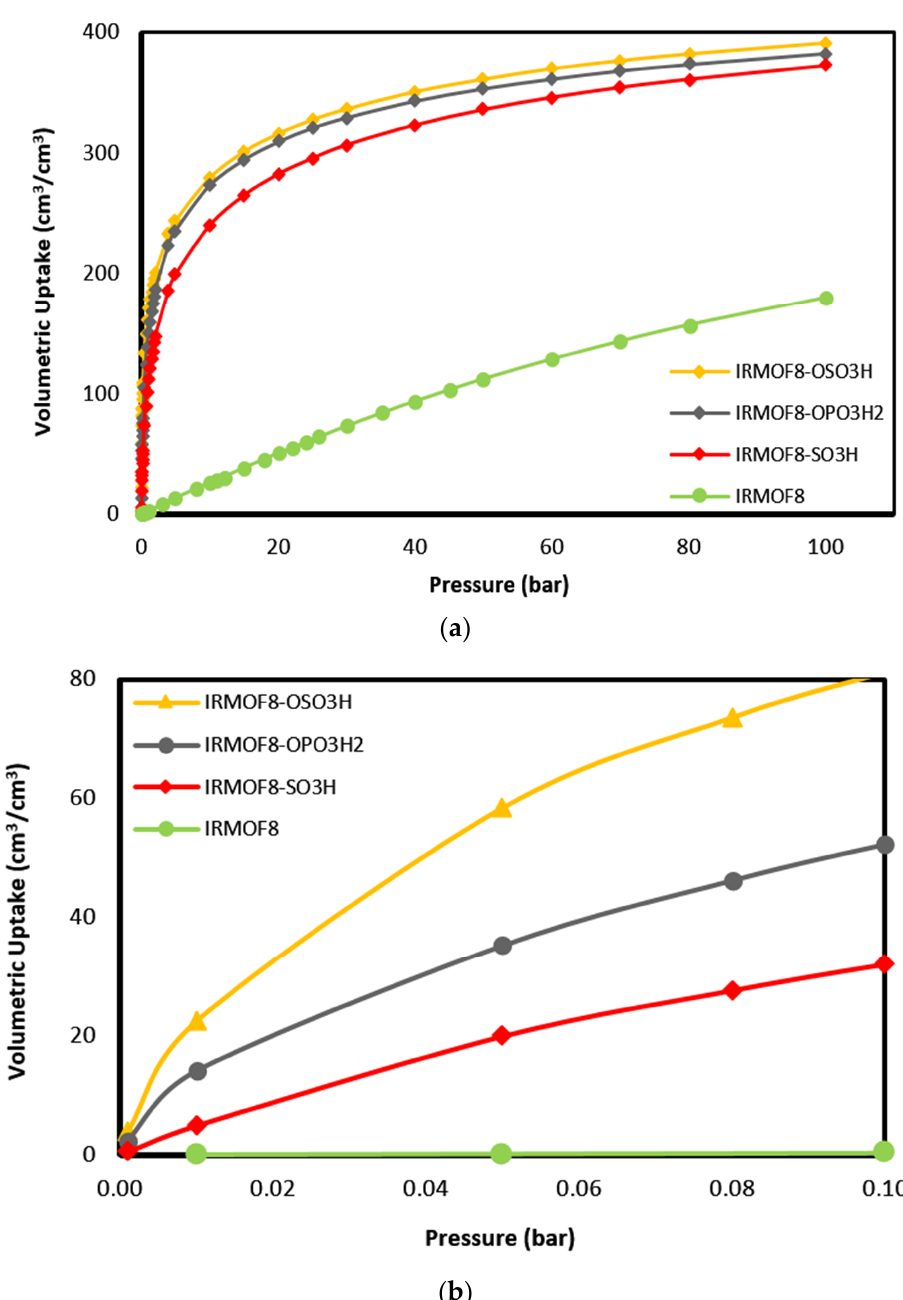
Figure 7. Absolute volumetric isotherms for IRMOF8 and IRMOF8-n (n: -OSO 3 H, -OPO 3 H 2 , -SO 3 H) at T = 298 K and pressure ranges up to ( a ) 100 bar and ( b ) 0.10 bar. This is further supported by snapshots obtained during the GCMC simulations at 0.6 bar and 298 K for the -OSO 3 H modified MOF and unmodified IR-MOF8 (Figure